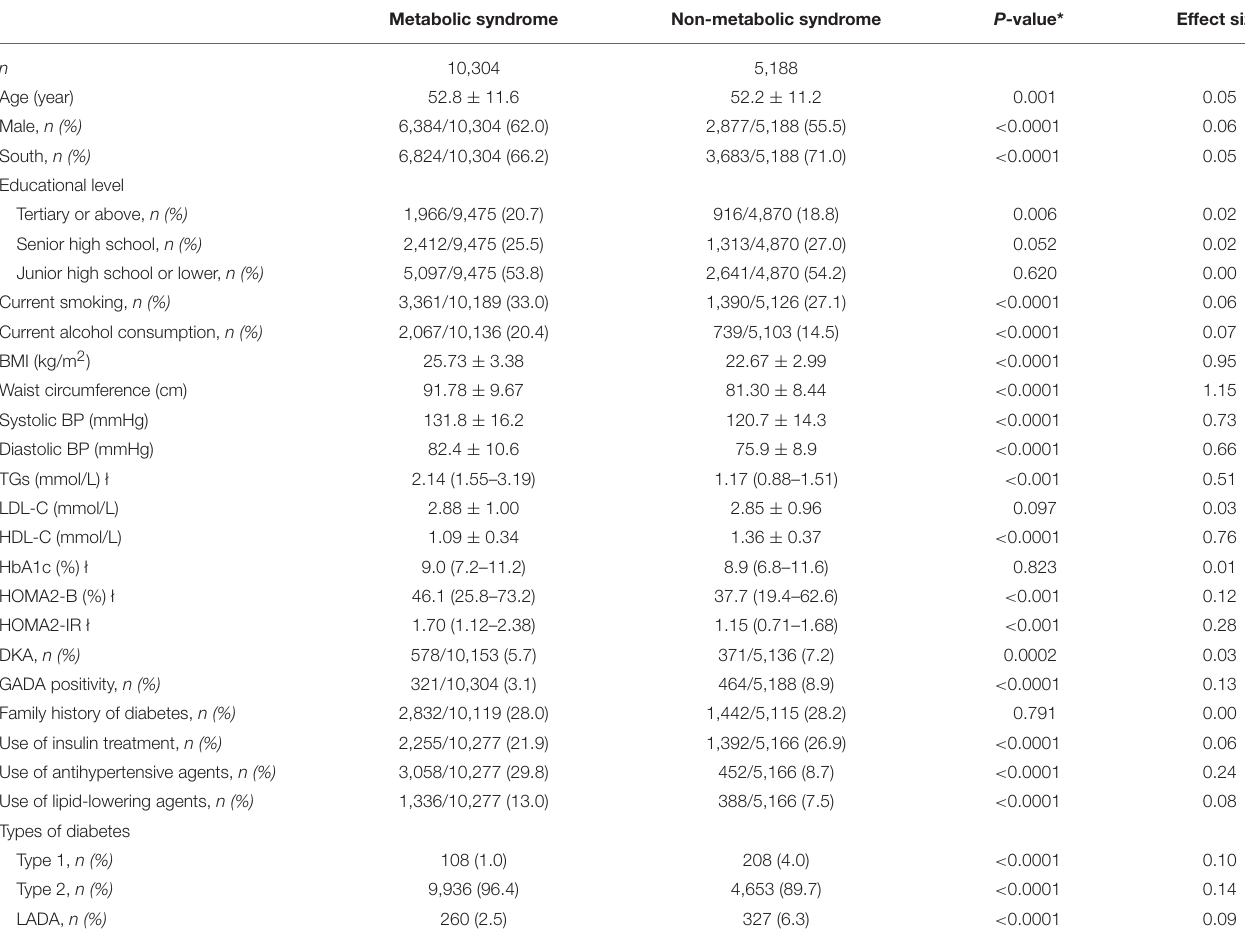
TABLE 1 | Demographic and clinical characteristics of the study patients stratified by metabolic syndrome. Metabolic syndrome Non-metabolic